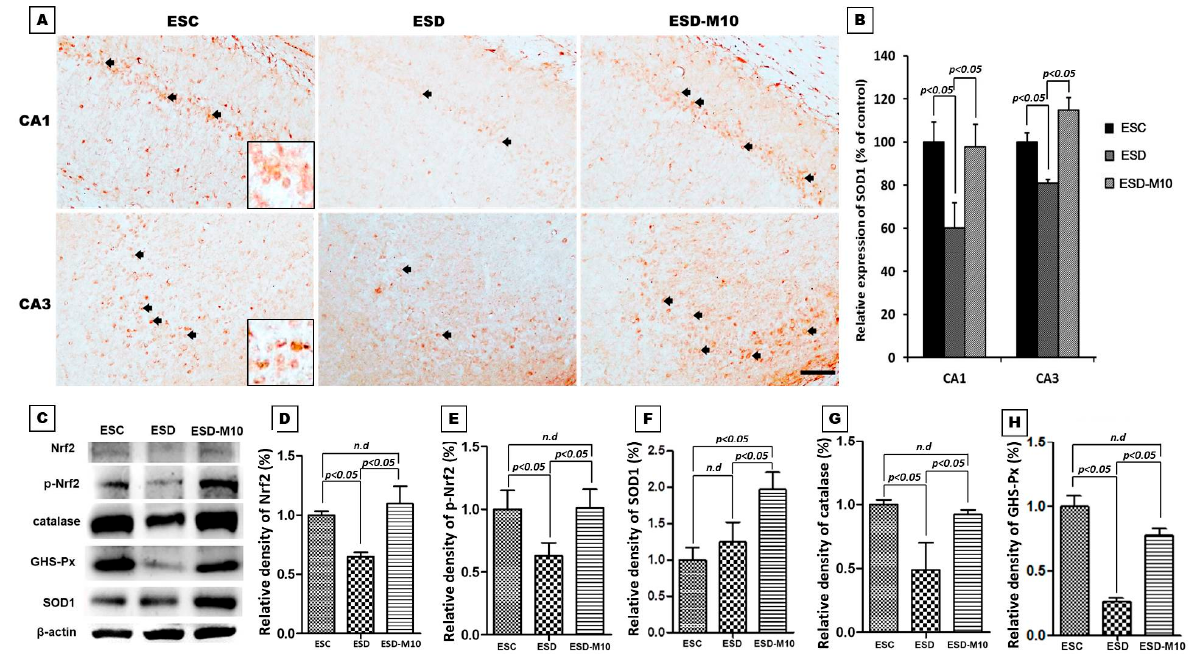
Figure 6. Photomicrographs ( A ) and histogram ( B ) show SOD1 expressions in the CA1 and CA3 region of the hippocampus based on immunohistochemistry results. Note that ESD rats showed decreased SOD1 expression in the hippocampus. In the ESC and ESD-M10 groups, hippocampal scheme 1 immune-expression significantly increased ( p < 0.05). Immunoblots ( C ) and histograms ( D – H ) show the expressions of Nrf2 (D), p-Nrf2 ( E ) and the downstream antioxidant enzymes including SOD1 ( F ), CAT ( G ), and GSH-Px ( H ) of ESD-M10 group which were higher than in ESD group ( p < 0.05). Note that melatonin effectively promotes anti-oxidative enzyme activities. Scale bars: 300 μ m.